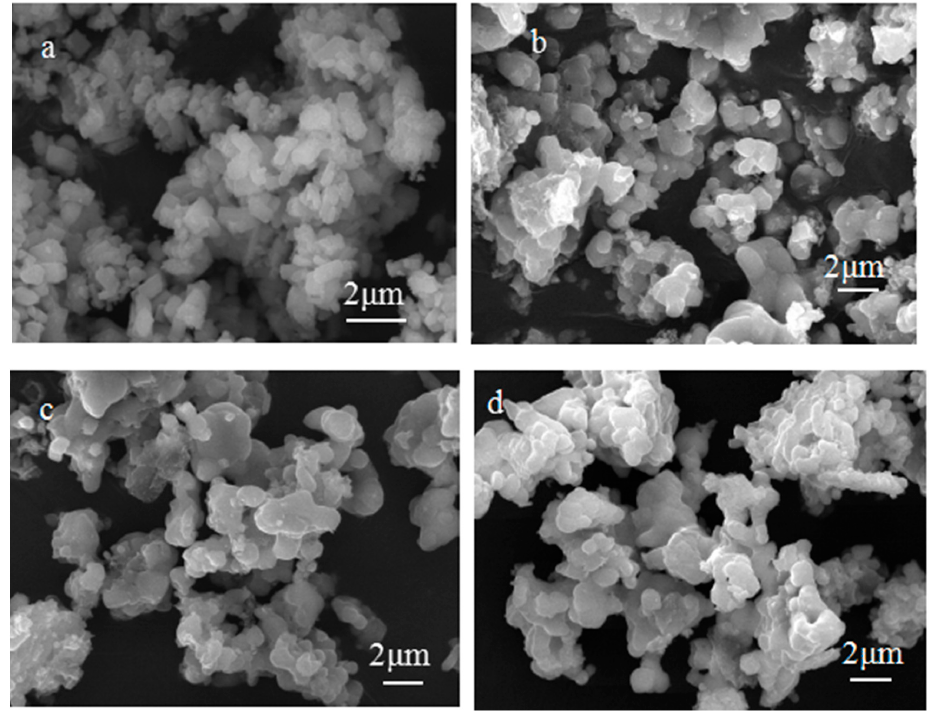
Figure 2. SEM micrographs of LiFePO 4 composites with different amounts of ZnO: ( a ) 0, ( b ) 1 wt%, ( c ) 3 wt%, and ( d ) 5 wt%.